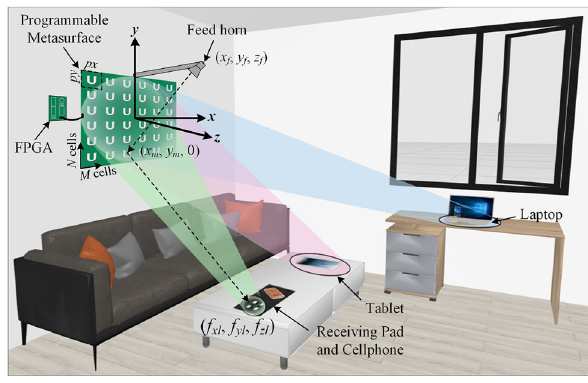
Figure 9: Adaptively intelligent wireless charging scenario using NFF programmable metasurface [76]. Reprinted from [77], with the permission of IEEE Publishing.